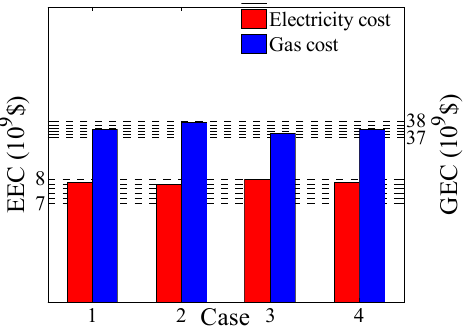
Figure 4. EEC and GEC in different cases.